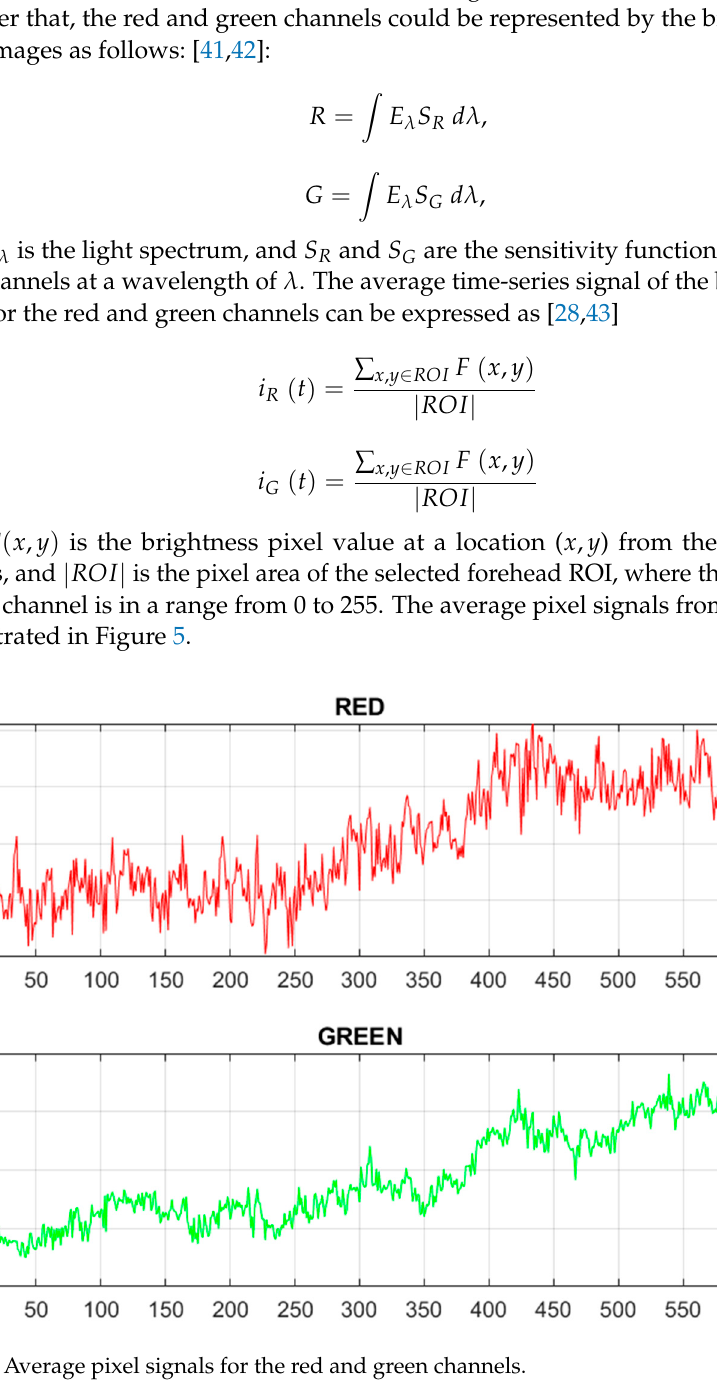
Figure 6. Signal decomposition of 𝑖 (cid:3019) (cid:4666)𝑡(cid:4667) using a complete EEMD technique with 100 realisations and 100 iterations with 0.2 noise standard deviation.